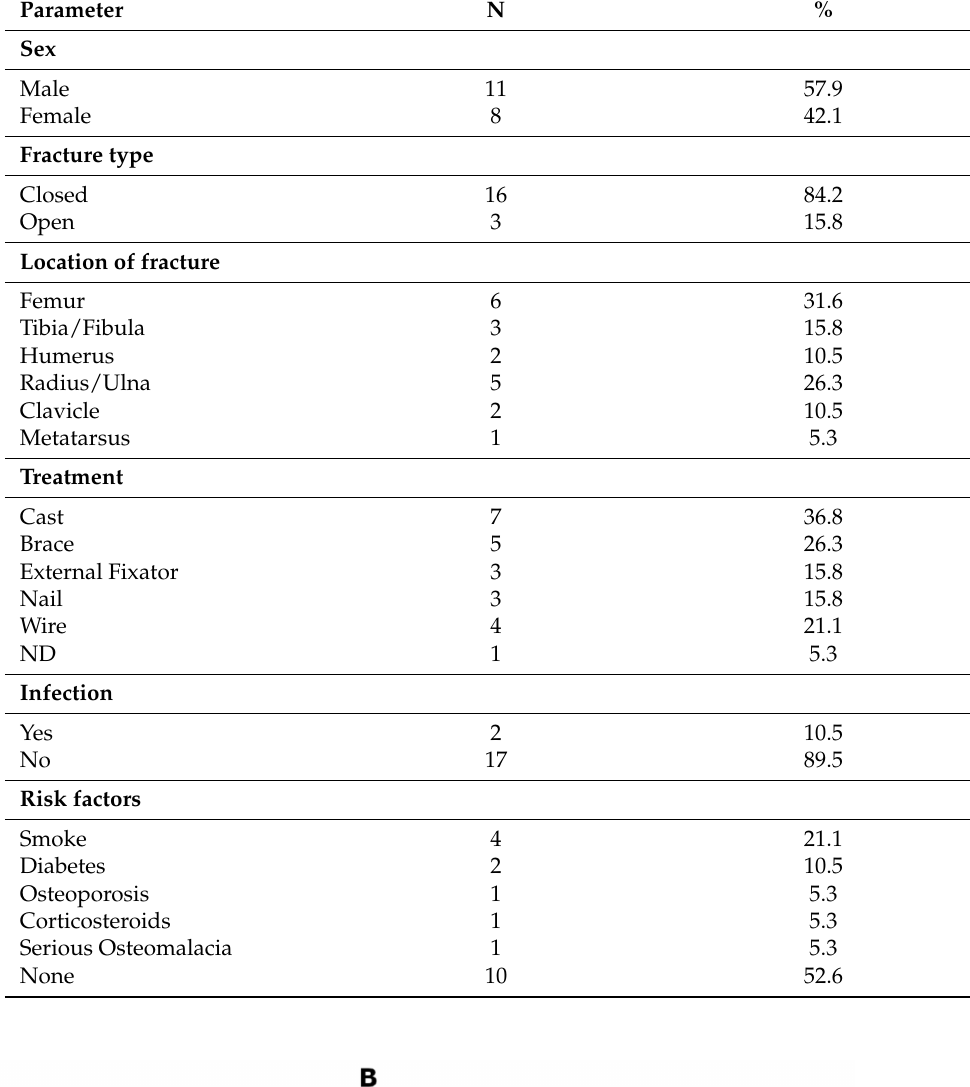
Table 2. Fresh fractures: demographics and clinical characteristics at baseline.